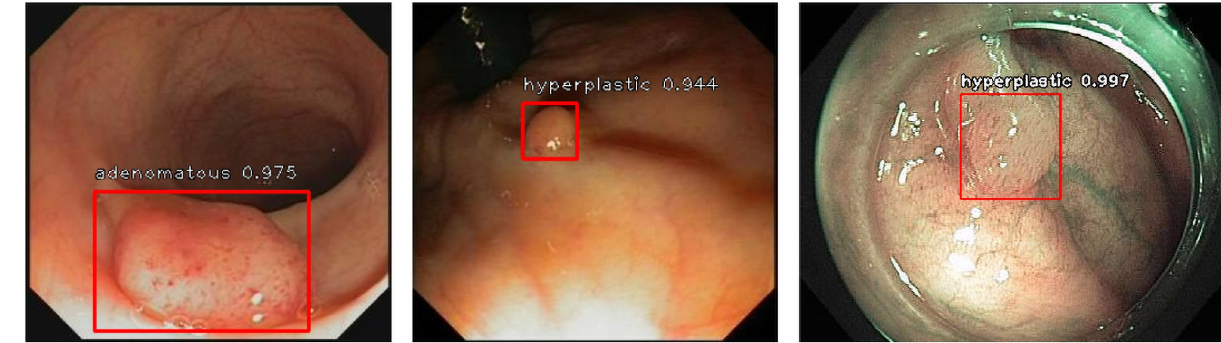
Fig 9. Three examples of the detection results with the predicted classes and confidence scores.